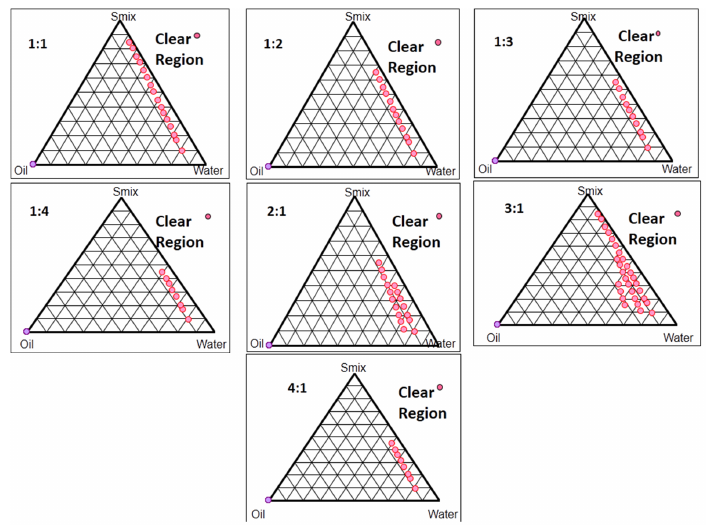
Figure 3. Pseudo-ternary phase diagrams depicting the existence of o/w nanoemulsion region (clear region) for different surfactants: co-surfactant ratios (or S mix ). 2.4. Optimization of Formulation Components for Nanoemulsion A total of 17 different formulations suggested by CCD were prepared using the ul- trasonication method, and the values for the droplet size (Y1), %transmittance (Y2), and %CDR (Y3) were in the range of 80.69–311.9 nm, 72.88–93.89%, and 22.06–94.92%, respec- tively. The experimental values and the predicted values for the dependent variables are summarized in Table 2. The optimization software proposed a polynomial quadratic ( p = 0.0004 for Y1 and p < 0.0001 for Y2 and Y3) for all three of the dependent variables when the observed data for the dependent variables were submitted to it. The predicted R 2 val- ues for all three dependent variables were in agreement with the adjusted R 2 values due to a difference of less than 0.2; these are summarized in Table 3 along with the mean, standard deviation, and coefficient of variation (%) for all the dependent variables. To predict the quantitative effects of all the independent variables with varying levels on the dependent variables, the software generated the polynomial equations for each response, which are the following: